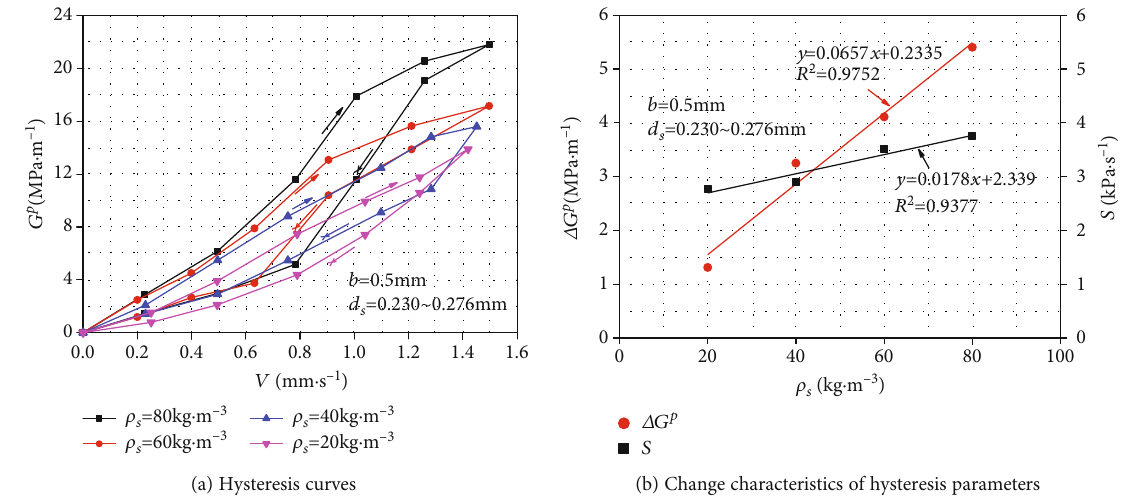
Figure 12: Hysteresis characteristics of water- fl ow seepage under the in fl uence of sand mass